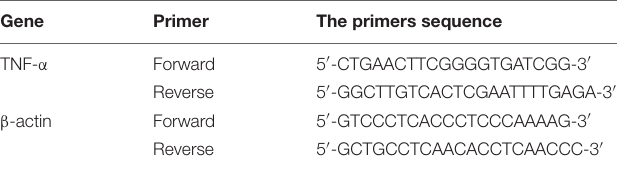
TABLE 1 | The primers